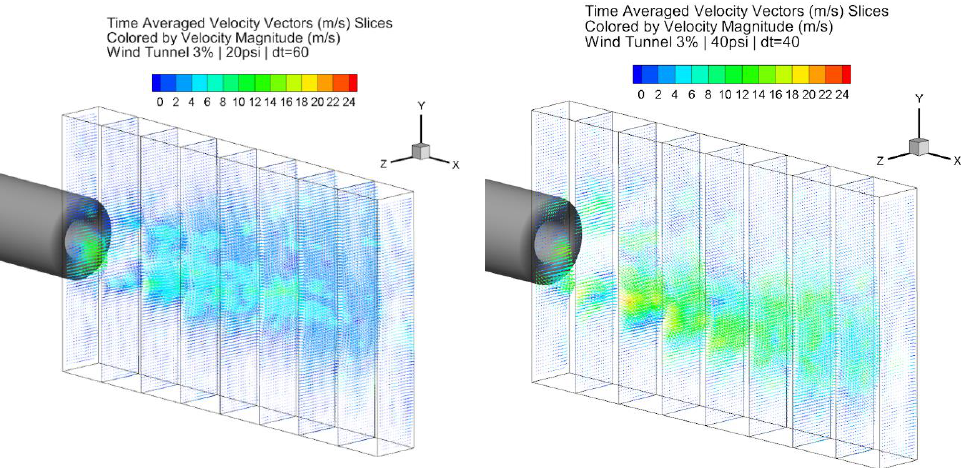
Figure 15. Time-averaged 3D velocity vector slices for 3% freestream at 20 and 40 psi cases.